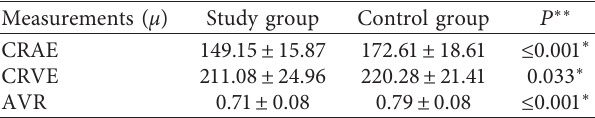
Table 3: Comparison of mean retinal vessel diameter measure- ments of the patients in the study group and the subjects in the control group (study group, n � 30; control group, n �